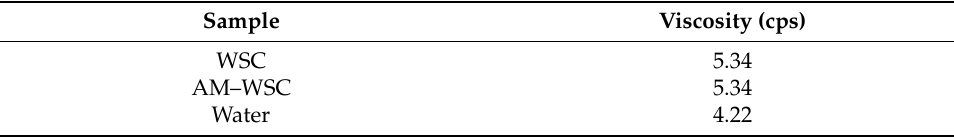
Table 2. Result of the physical evaluation of the